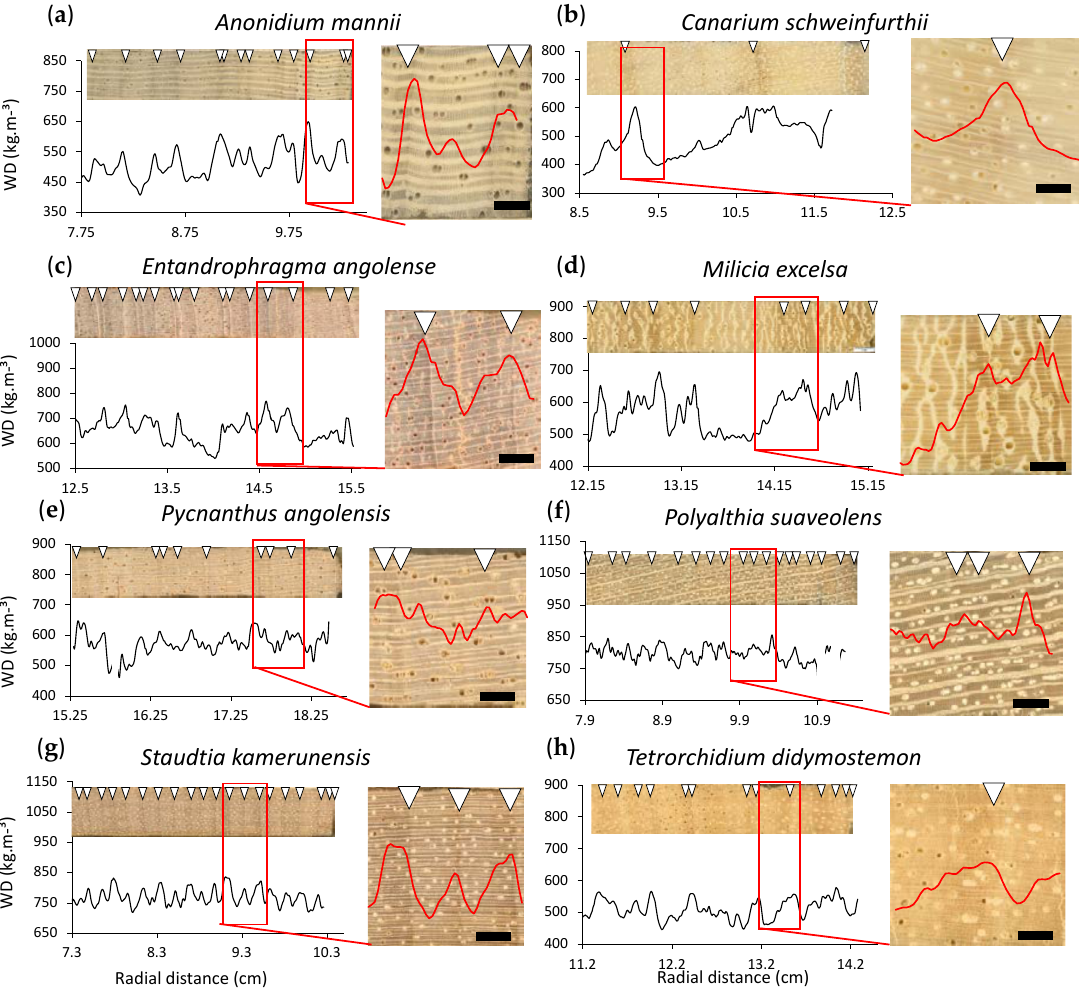
Figure 4. Visual interpretation of the density profile. Sanded wood core sections in upper panel, where ring widths were indicated. The outermost section of density profiles of 8 selected species from the Congo Basin, with a zoom showing to what extent the ring boundaries visually indicated with white triangles on the wood surface, concur with the density profile at the ring boundary. Wood density is defined as the ovendry wood density (kg · m − 3 ). Species shown are ( a ) Anonidium mannii , ( b ) Canarium schweinfurthii , ( c ) Entandrophragma angolense , ( d ) Milicia excelsa , ( e ) Pycnanthus angolensis , ( f ) Polyalthia suaveolens , ( g ) Staudtia kamerunensis , and ( h ) Tetrorchidium didymostemom . Scalebar 500 µ